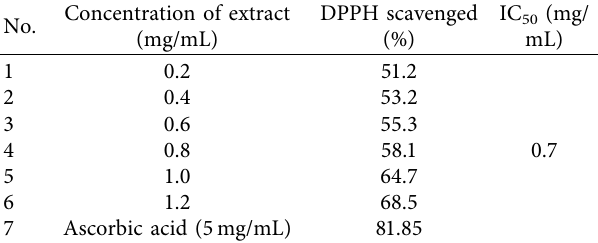
Table 4: DPPH assay of methanol extract of hibiscus flower. Concentration of No.